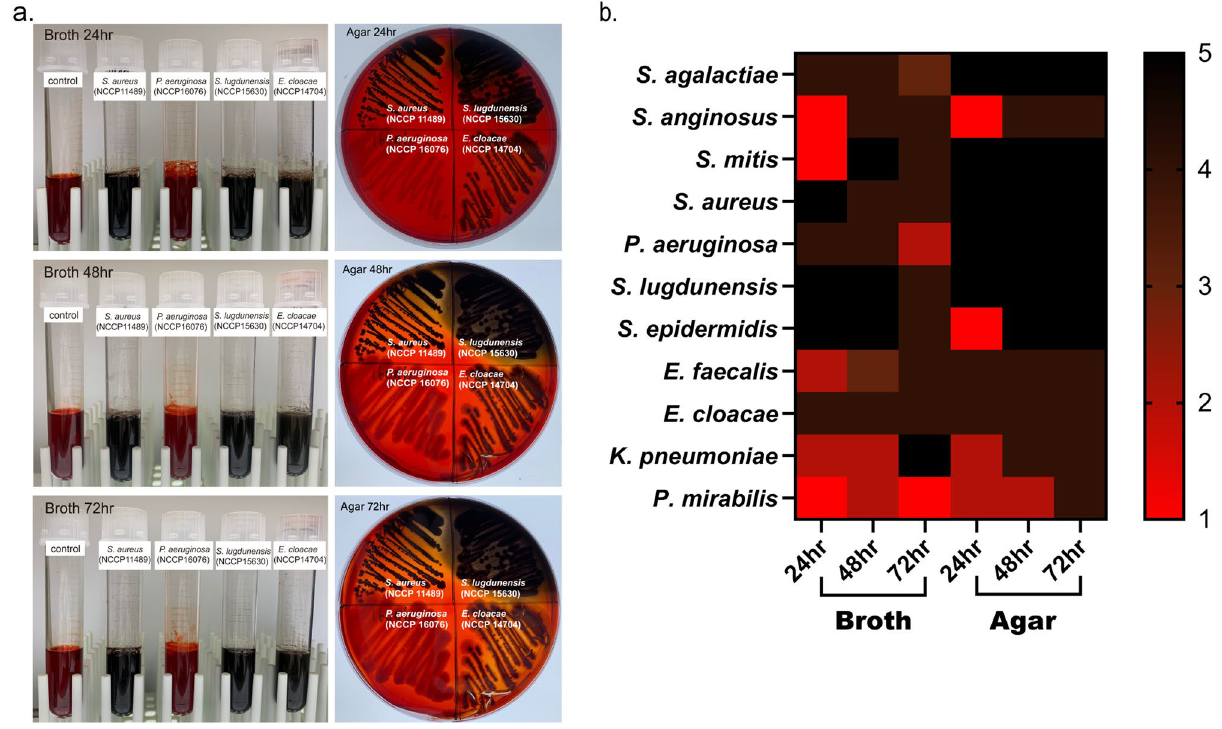
Figure 1. Congo red tests to screen biofilm production of microorganisms. ( a ). Representative images of Congo red tests with broth culture (left) and agar plates (right) at 24-, 48-, and 72-h time points. ( b ) Heatmap for Congo red test results of 11 microorganisms used throughout this study. Each number on the scale bar indicates the media color as follows: 1 = red, 2 = dark red, 3 = brown, 4 = dark brown, 5 =